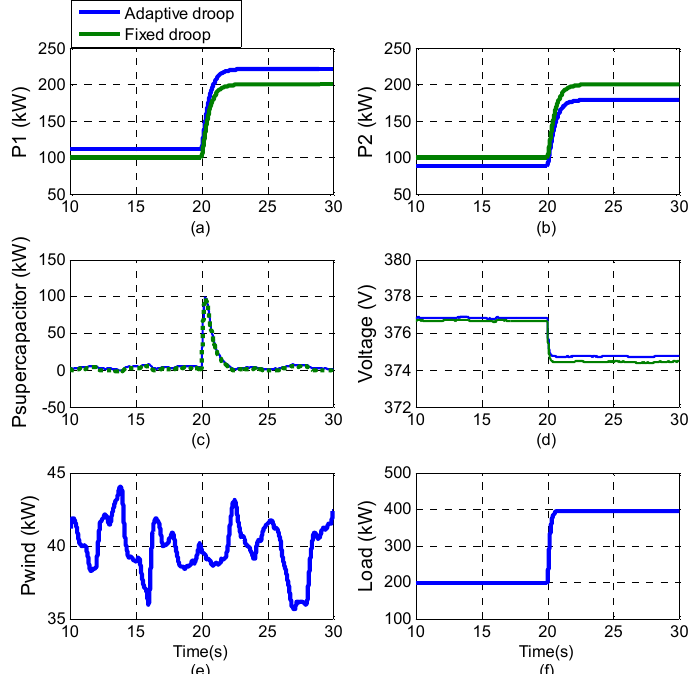
Figure 13. Transients of the system when the load is changed from 200 to 400 kW. ( a ) Output power of BESS 1 ; ( b ) Output power of BESS 2 ; ( c ) Output power of Supercapacitor; ( d ) DC voltage; ( e ) Output power of wind unit and ( f ) Load profile.